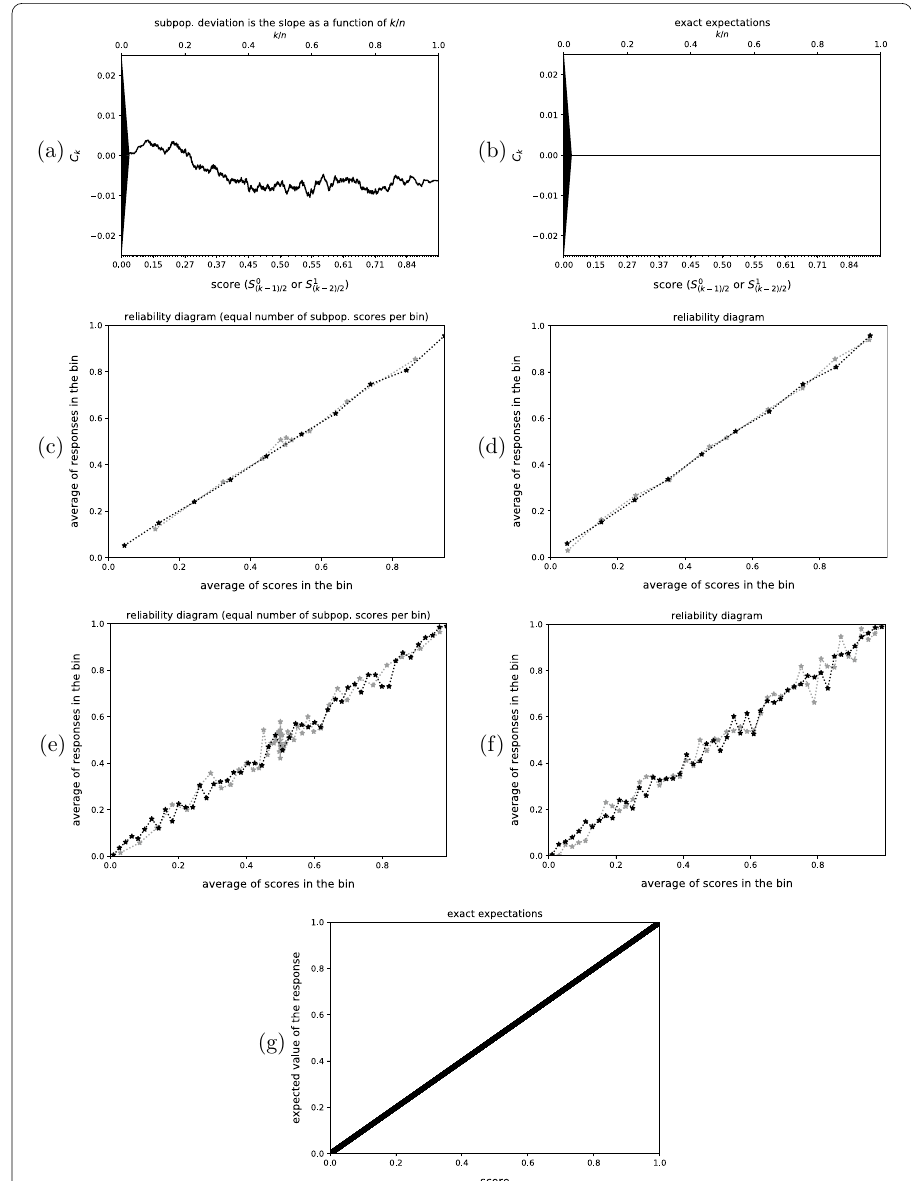
Fig. 6 n = 6451; Kuiper’s statistic is 0.01429 /σ = 1.148 , Kolmogorov’s and Smirnov’s is 0.01046 /σ = 0.8402 ; the stochastic variations in the empirical cumulative graph ( a ) are clearly within the expectations indicated by the triangle at the origin—the graph looks like a perfectly random walk, and indeed really is a drift-free, perfectly random walk. The statistics of Kuiper and of Kolmogorov and Smirnov give no indication of any statistically significant deviation between the subpopulations, as both are less than 1.25 σ —the expected value for the metric of Kolmogorov and Smirnov in the absence of any deviation between the subpopulations’ expected responses, as detailed by Remark 2 of